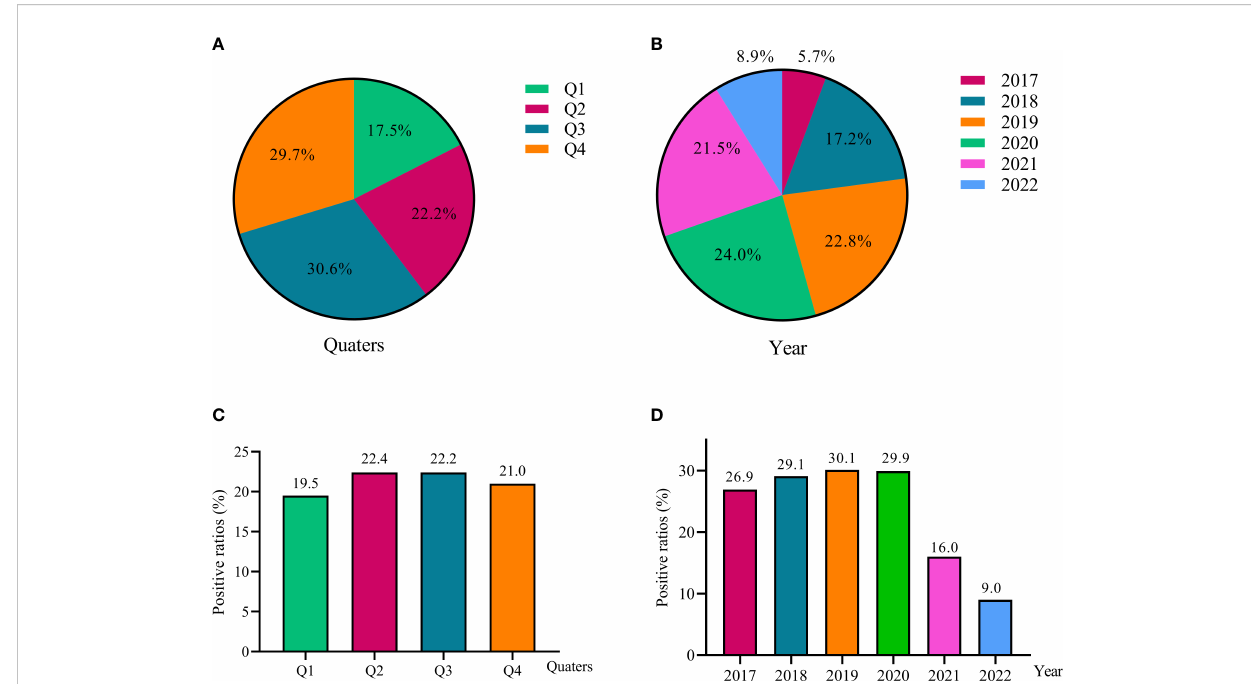
FIGURE 1 EBV detection among children from 2017 to 2022. The constituent ratios of EBV-positive cases in different quarters (A) and different year (B) ; The positive ratios of EBV detection in different quarters (C) and different year (D)